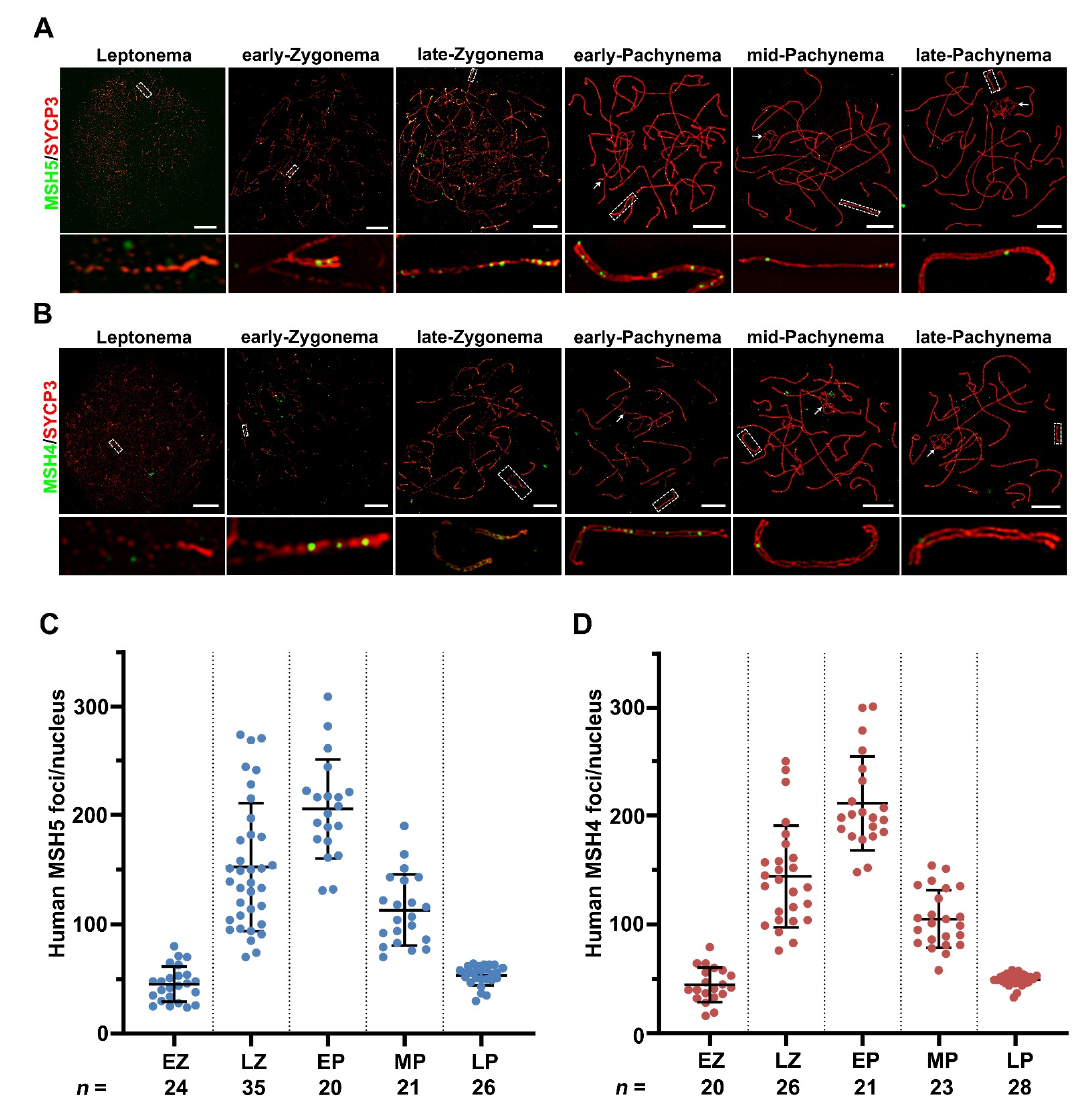
Figure 3. The super-resolution localization of human MSH5 and MSH4 on meiotic chromosomes. ( A , B ) The super-resolution images of human surface-spread spermatocytes showing the localization of human MSH5 ( A ) and MSH4 ( B ) on meiotic chromosomes. Early-, mid-, and late-pachynema were distinguished based on the XY morphology and SYCP3 staining pattern Arrowheads indicate the XY chromosomes. Enlarged view of the boxed individual chromosomes are shown below the overlay images. Scale bars, 10 μ m. ( C , D ) Numbers of the MSH5 ( C ) and MSH4 ( D ) foci per nucleus at successive prophase stages (EZ, early-zygonema; LZ, late-zygonema; EP, early-pachynema; MP, mid-pachynema; LP, late-pachynema). Horizontal bars represent the mean ± SD. n represents the number of nuclei analyzed at EZ, LZ, EP, MP, and LP, respectively.